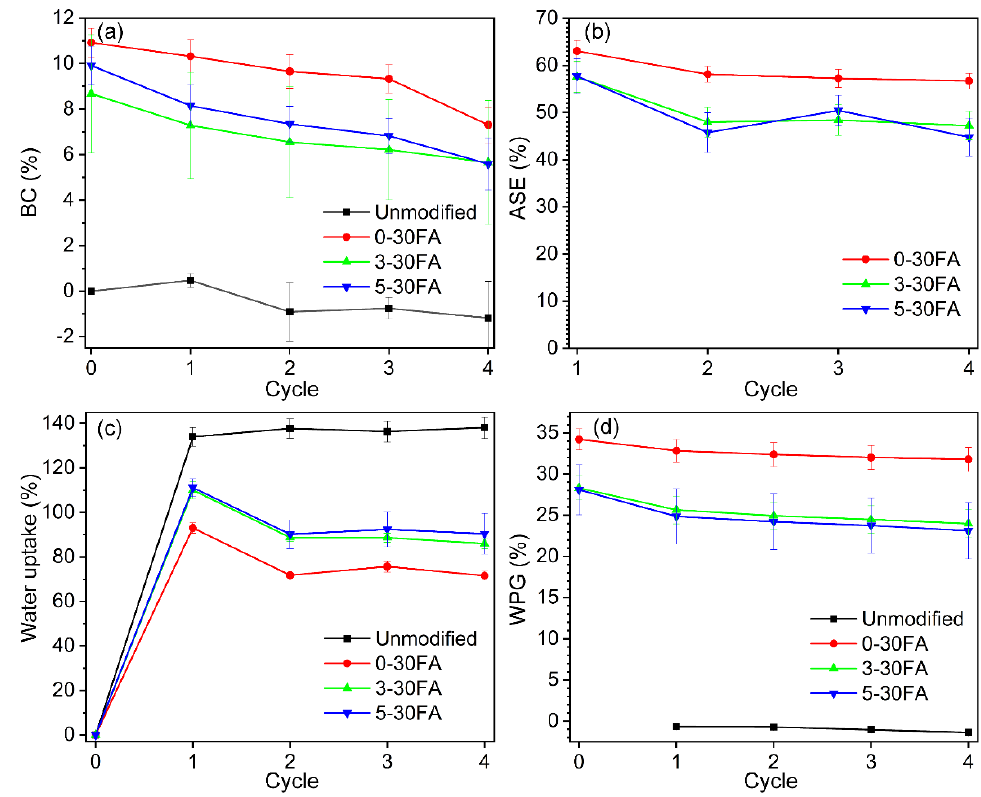
Figure 9. Performance of fire-retardant treated furfurylated sapwood of Scots pine: ( a ) bulking coefficient (BC), ( b ) anti − swelling efficiency (ASE), ( c ) water uptake, and ( d ) weight percentage gain (WPG) of unmodified specimen and of 0-30FA, 3-30FA, and 5-30FA modified specimens over the wet − dry cycle test.